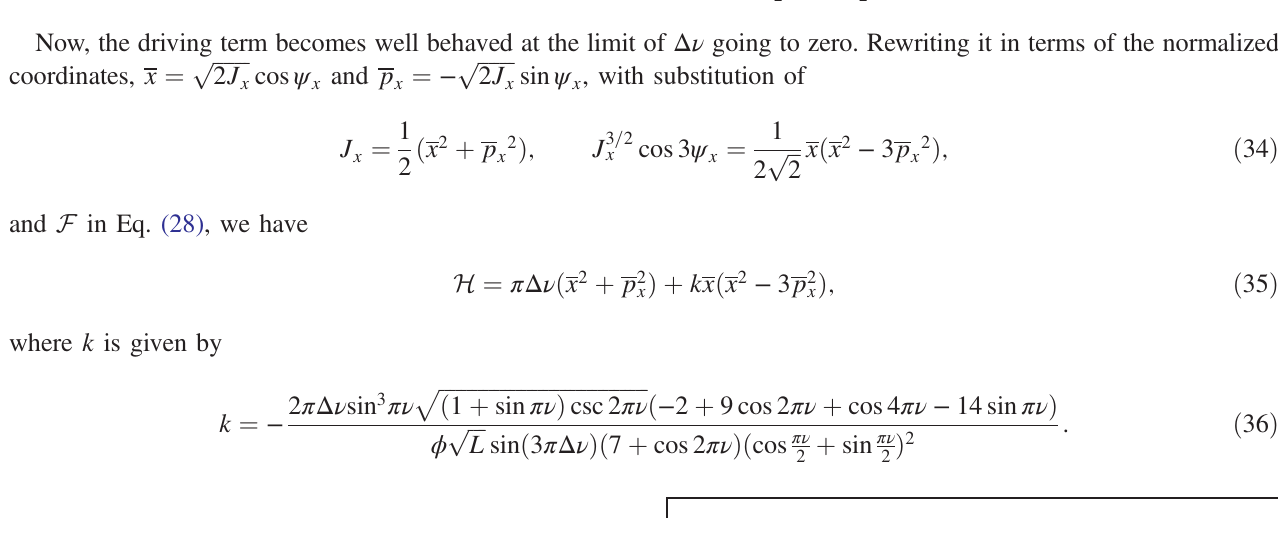
Fig. 4. The contours including the separatrices agree with the results [6,21] derived from the Hamiltonian theory or the Lie algebra method. The tracking orbits and the contours from the theory are in excellent agreement.